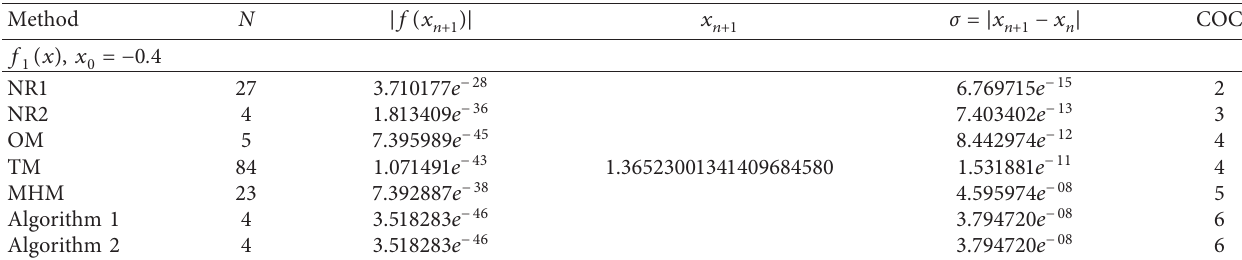
Table 1: Comparison of various iterative methods.